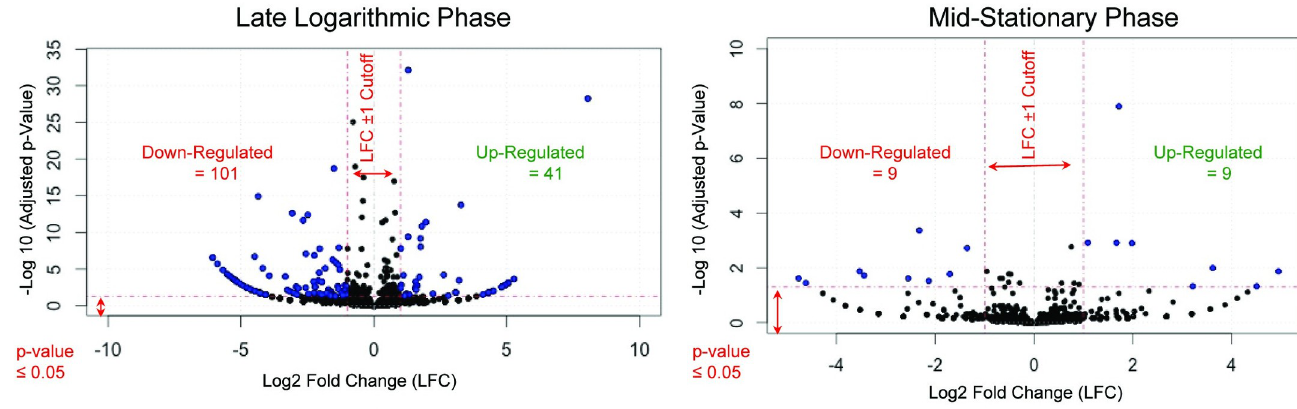
Fig 1. Cellular protein abundances of T . lignolytica BRL6-1 grown in lignin-amended relative to unamended conditions. Blue dots represent significant change in protein abundance in lignin-amended conditions (p-value < 0.05) relative to unamended conditions whereas black dots denote represent proteins that did not change between lignin-amended and unamended